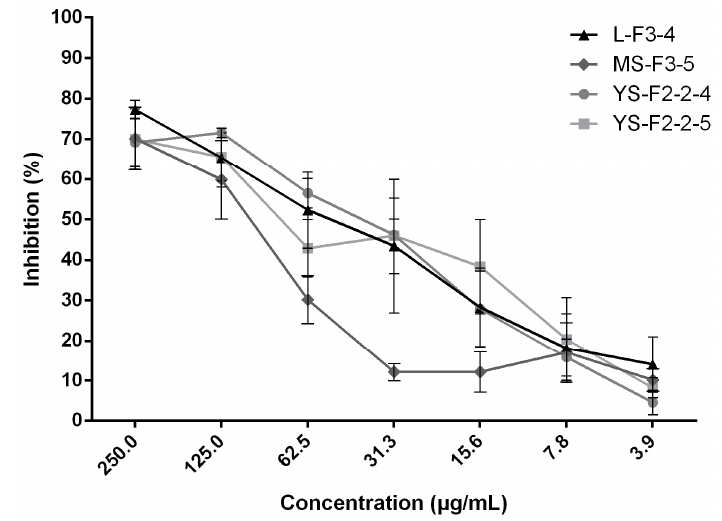
Figure 2. Anti-biofilm growth activity of the 4 subfractions L-F3-4, MS-F3-5, YS-F2-2-4 and YS-F2-2-5 enriched in active compounds. Results are expressed as mean of the inhibition percentages of C. albicans biofilm growth ± standard deviations depending on the concentrations of the subfractions. All experiments were performed in